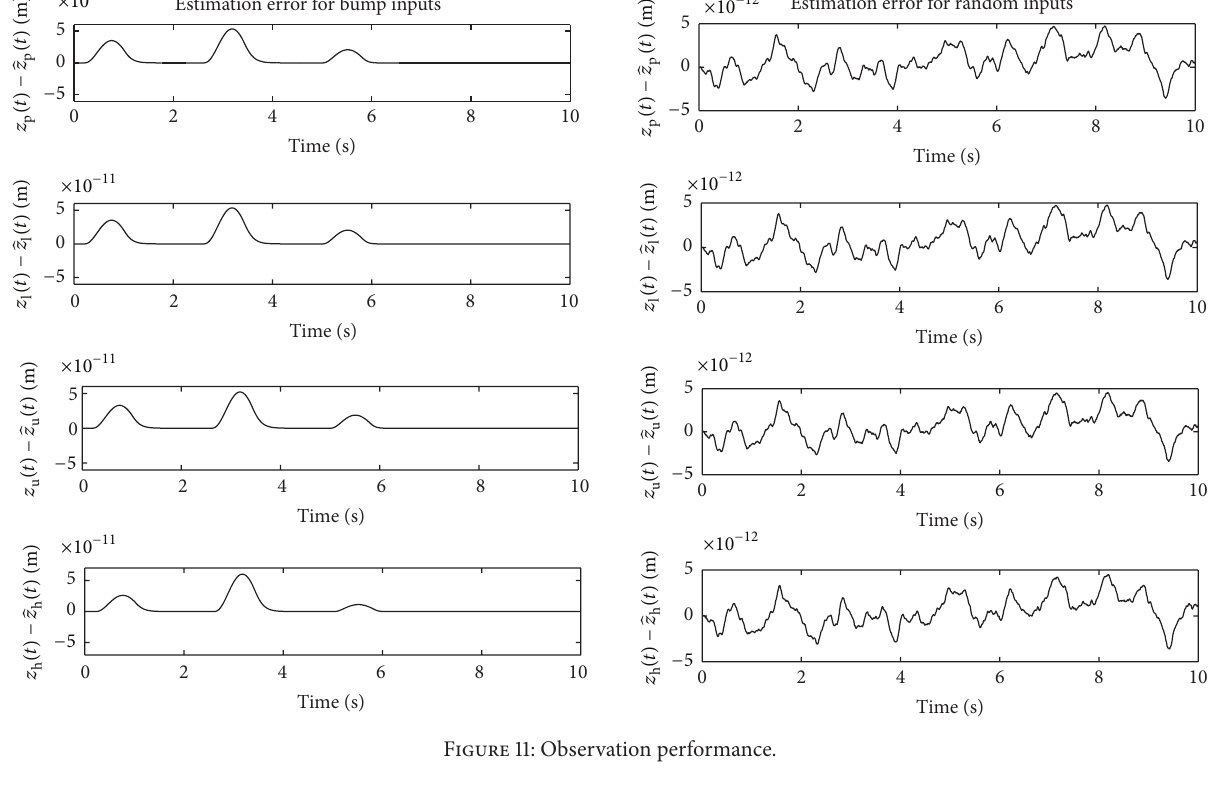
Figure 11: Observation performance.